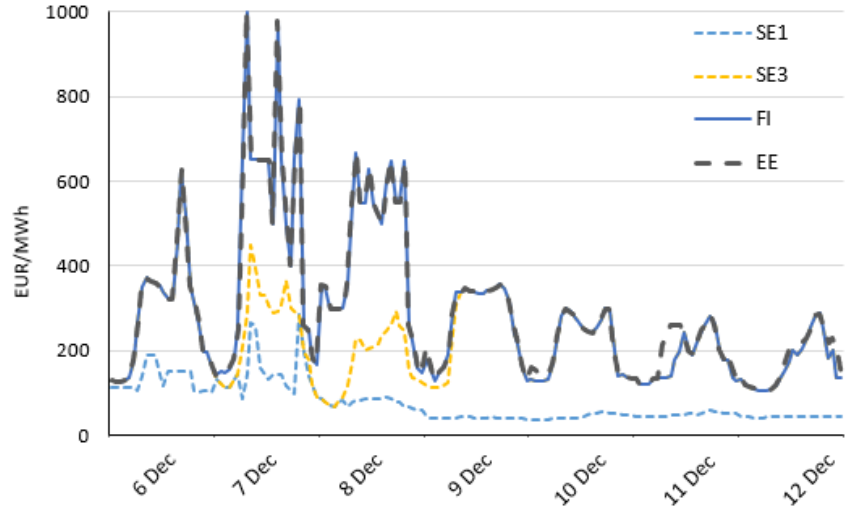
Figure 5. Hourly day-ahead prices between 6–12 December in Finland, Estonia, SE1, and SE3. During the price peaks, Estonia was importing both from Finland and Latvia, as seen from Figure 6, thus setting the power price on that hour. The dotted lines in Figure 6 represent the available day-ahead capacities for the interconnectors between the relevant bidding zones (SE1–FI, SE3–FI, FI–EE, and LV–EE) and the blue line shows the scheduled commercial flows [1,21]. As the capacities of FI–EE and LV–EE interconnectors were not congested, the markets did not decouple during the peak. In practice, when the blue line touches the dotted line, the markets decouple. Finland was also importing from Russia, but as it is not a part of the internal electricity market in Europe, it does not directly impact price formation in the market [22].